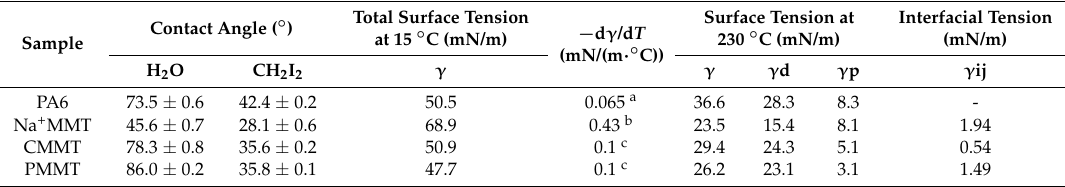
Table 3. Contact angle measurement results for PA6 and